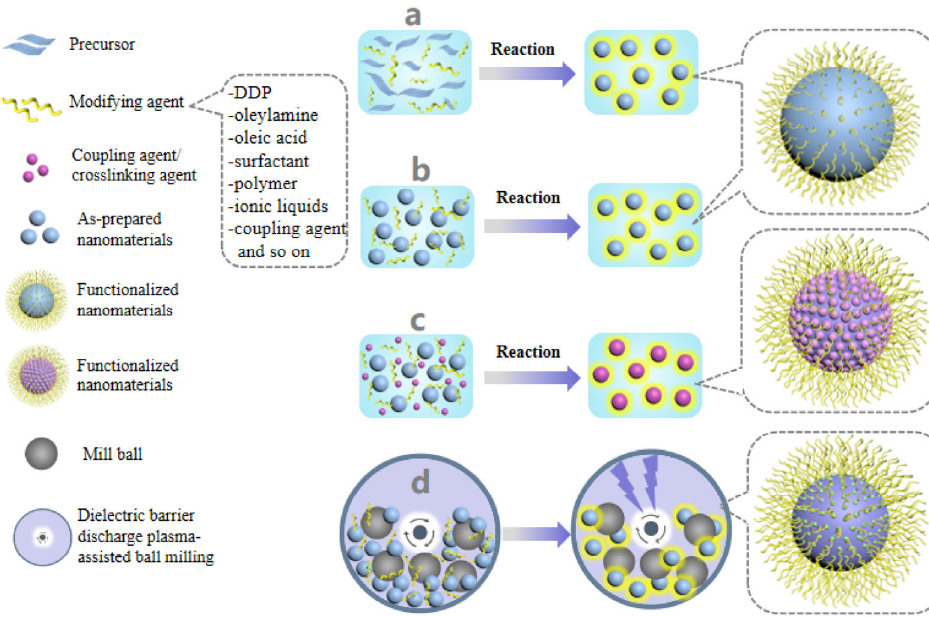
Fig. 4 Four preparation methods of functionalized nanomaterials (DDP: